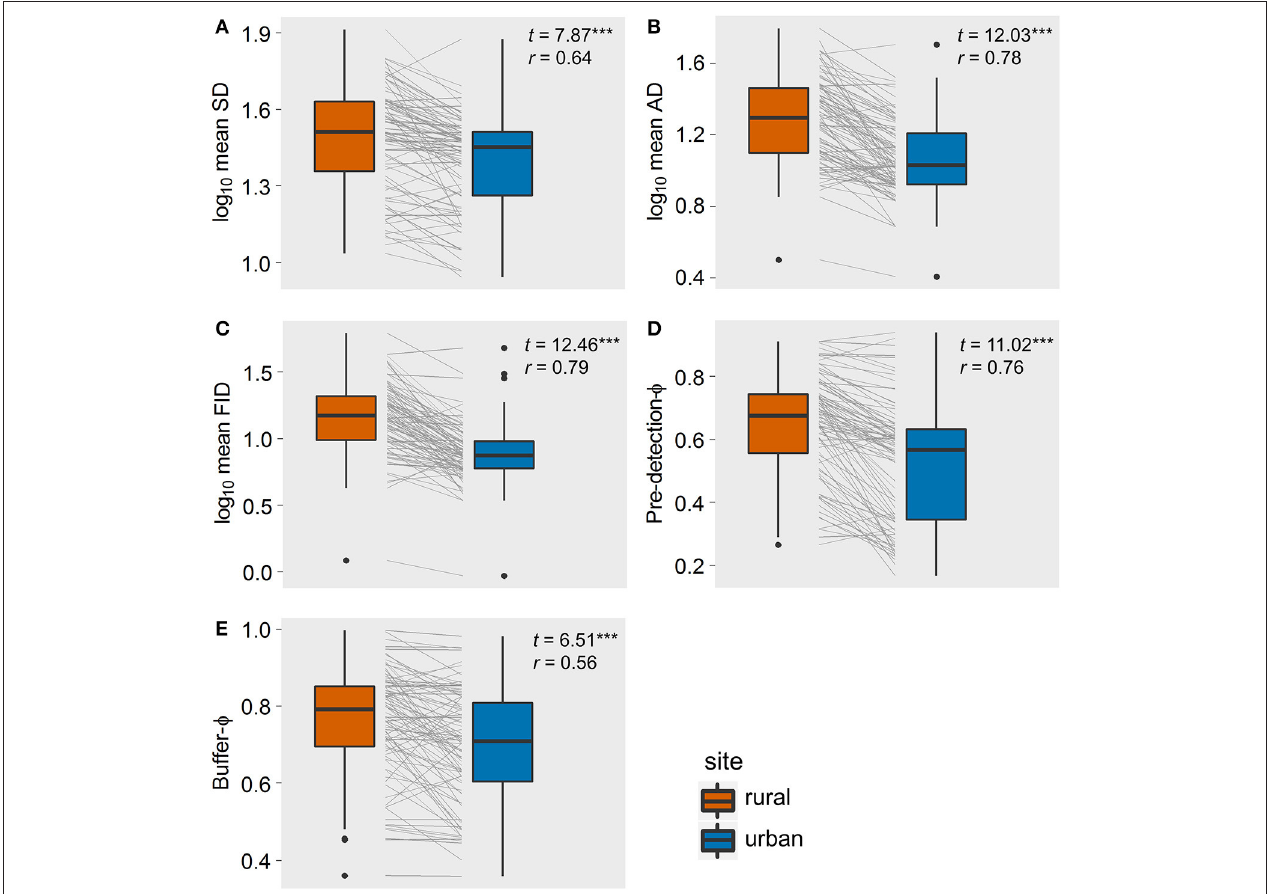
FIGURE 2 | The rural-urban differences of five components of escape behavior of the 92 bird populations studied in Europe: (A) starting distance, SD; (B) alert distance, AD, (C) flight initiation distance, FID; (D) pre-detection- 8 (lower values mean that birds took longer to be alerted to an approaching human); (E) buffer- 8 (lower values mean that birds tolerate more human approach after detection). Box-plots show median, quartiles, 5- and 95-percentiles and extreme values. Each population’s trajectory is illustrated with a gray line. t -values and effect sizes calculated as partial correlation coefficients are shown. All t -values were highly significant (*** P <